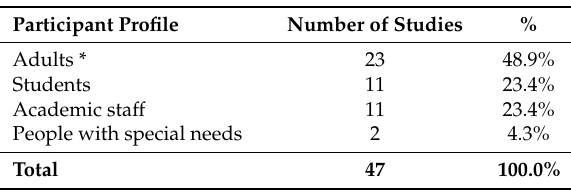
Table 7. Participant profile in gesture elicitation